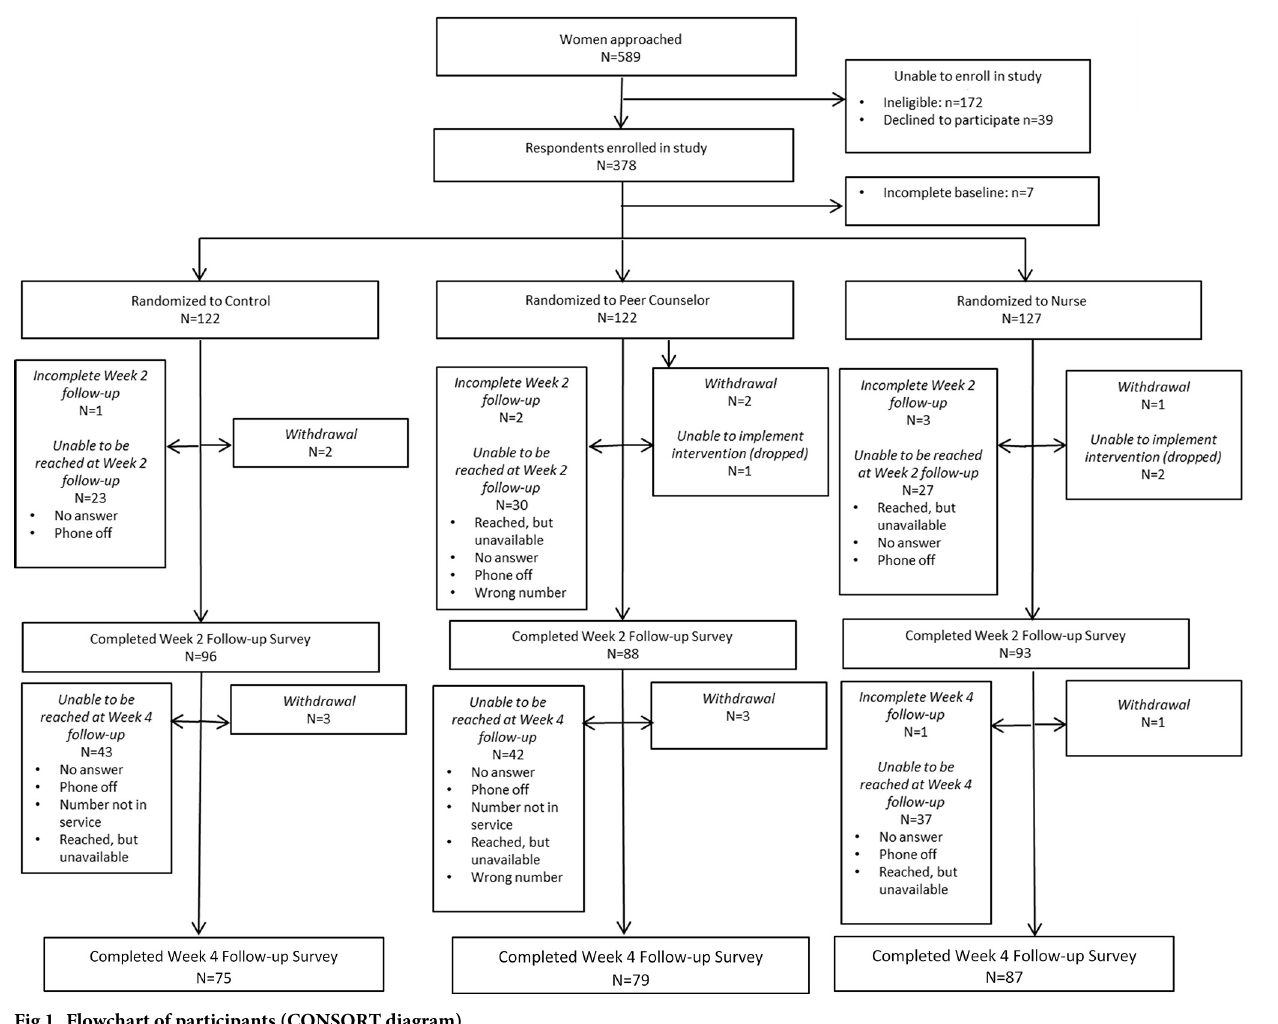
Fig 1. Flowchart of participants (CONSORT